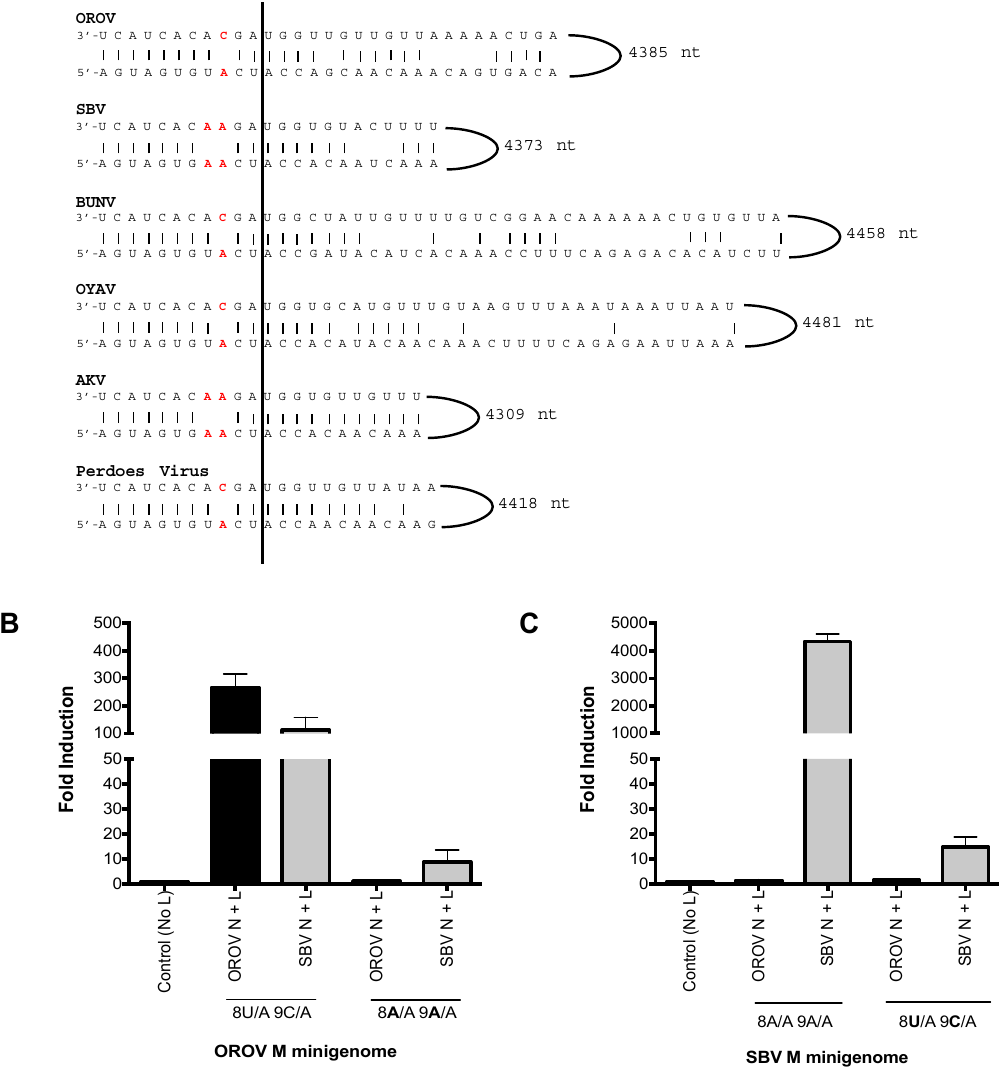
Figure 3. Analysis of the Simbu medium segment untranslated region (M UTR). ( A ) Sequence comparison of the 3 ′ and 5 ′ panhandle nucleotides of the M segments of Oropouche virus (OROV) (GenBank accession no, KP052851), Schmallenberg virus (SBV) [18], Bunyamwera virus (BUNV) (GenBank accession no, NC_001926), Oya virus (OYAV) (GenBank accession no, JX983193), Akabane virus (AKV) (GenBank accession no, NC_009895) and Perdoes virus (GenBank accession no, KP691628). OROV, BUNV, OYAV, and Perdoes viruses contain a single mismatch at position nine (8A/U 9C/A), whereas SBV and AKV contain a double mismatch at positions eight and nine (8A/A and 9A/A). These mismatches have been highlighted in red in the sequence alignment. ( B , C ) Minigenome assays. Performed as described above. Error bars indicate SD ( n = 3).